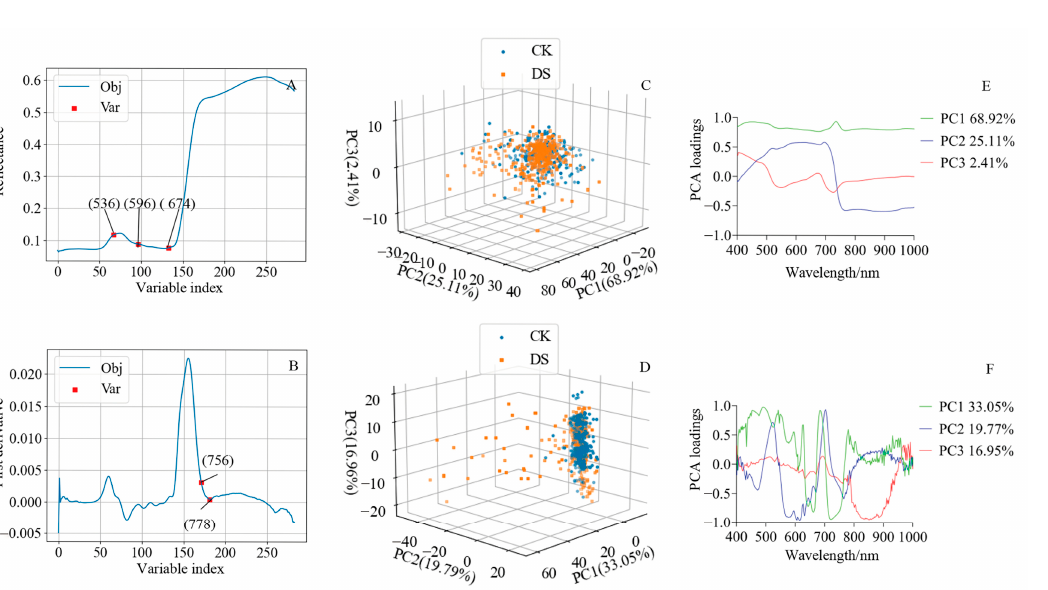
Figure 4. SPA feature band selection and PCA dimension reduction. ( A , B ) Spectral reflectance and first derivative bands extracted by SPA; ( C , D ) 3D spatial distribution of the first three principal components of spectral reflectance and the first derivative; ( E , F ) the first three principal components’ loadings of spectral reflectance and the first derivative. Python 3.6 was used to extract SPAD characteristic bands. Prism 9 was used to calculate PCA loadings. The percentage is the proportion of the variance explained by each principal component. SPA, successive projections algorithm; PCA, principal component analysis. Obj, first calibration object; Var, selected variables. CK, control; DS, drought stress.